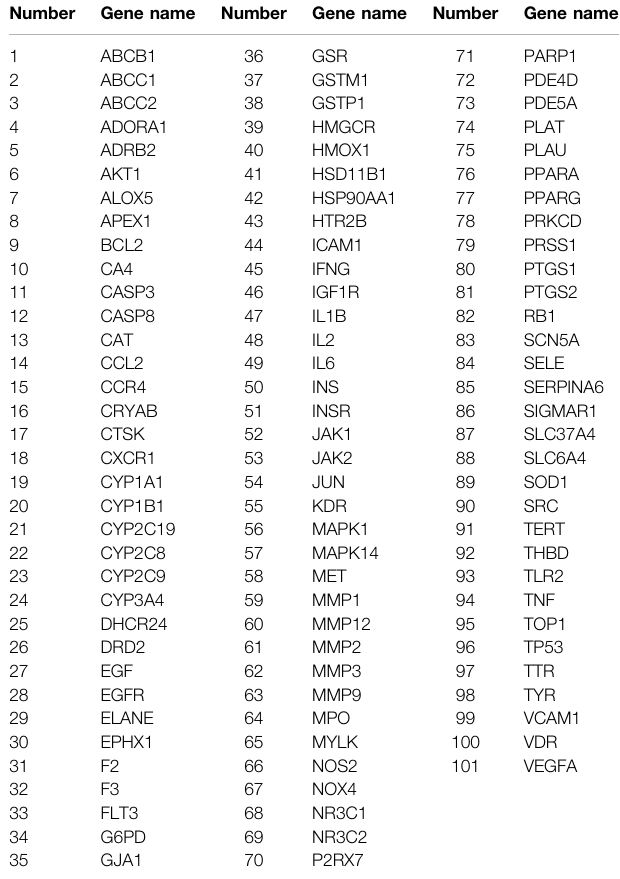
TABLE 2 | Shared hub targets between H. cordata and pulmonary fi